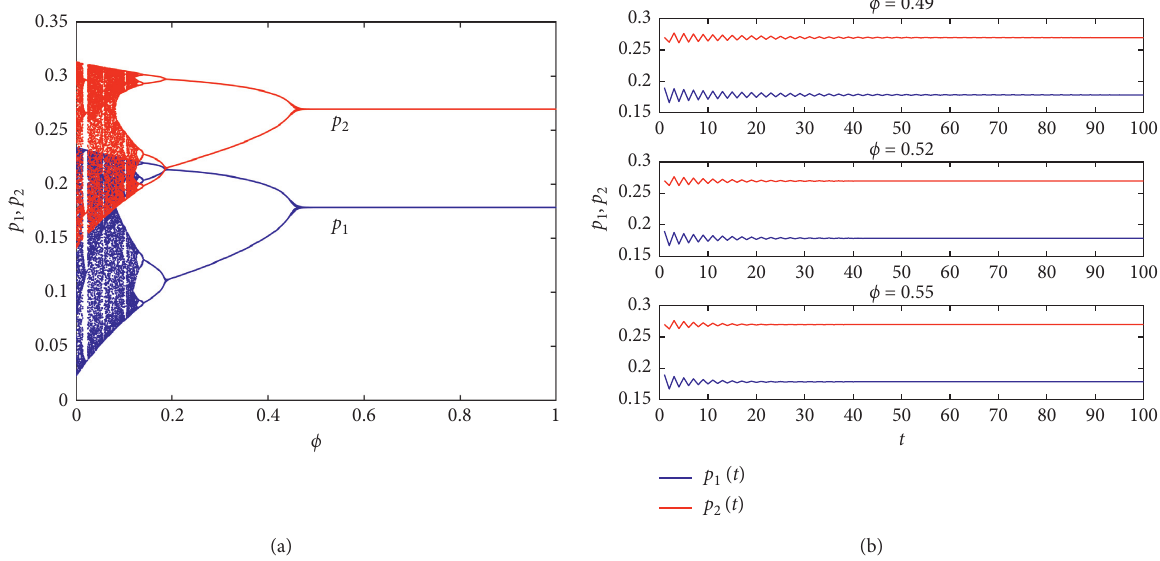
Figure 9: (a) Bifurcation diagram for system (60) with respect to the controlling factor ϕ . (b) Evolutions for system (60) with various values of ϕ .